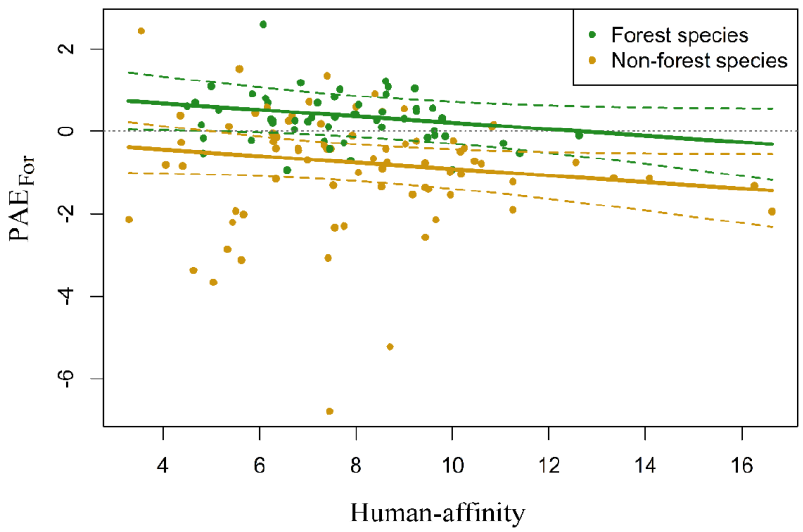
Figure 3: Effect of human-affinity (higher for species found preferably in areas of higher human footprint) on species’ responses to Protected Areas within forest routes (PAE For , above zero for species whose abundance in forest routes is higher in protected rather that in unprotected areas). Forest species (green) are species whose main habitat is “forest”, “conifer forest”, “mixed forest” or “deciduous forest”; non - forest species (brown) are all other species. Lines correspond to the effect of human-affinity on PAE For for deciduous forest species (green) and semi-open species (brown), predicted by the linear model and their 95% confidence intervals in dashed